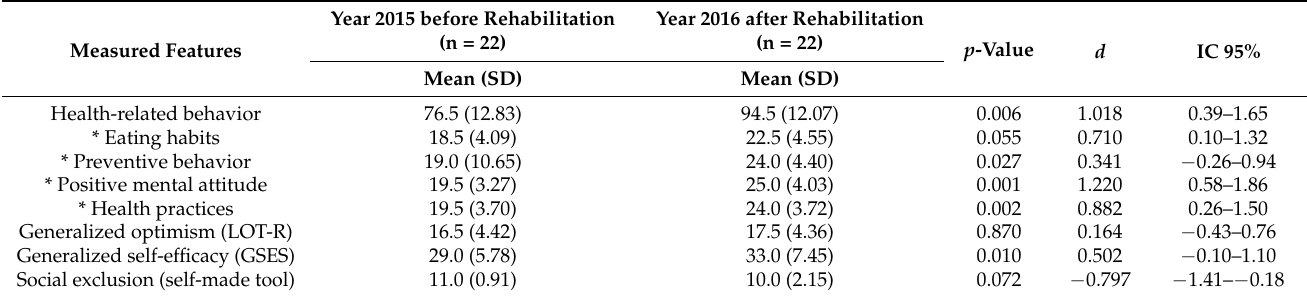
Table 1. Mean scores obtained from four questionnaires used at the beginning and end of the 6-month rehabilitation program.